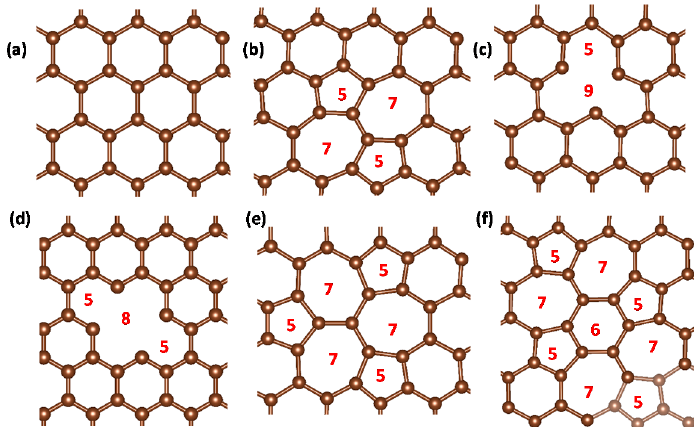
Figure 1. Geometric structure of pristine and defected graphene. ( a ) Pristine, ( b ) SW (55-77), ( c ) D1 (5-9), ( d ) D2_I (5-8-5), ( e ) D2_II (555-777) and ( f ) D2_III (5555-6-7777).